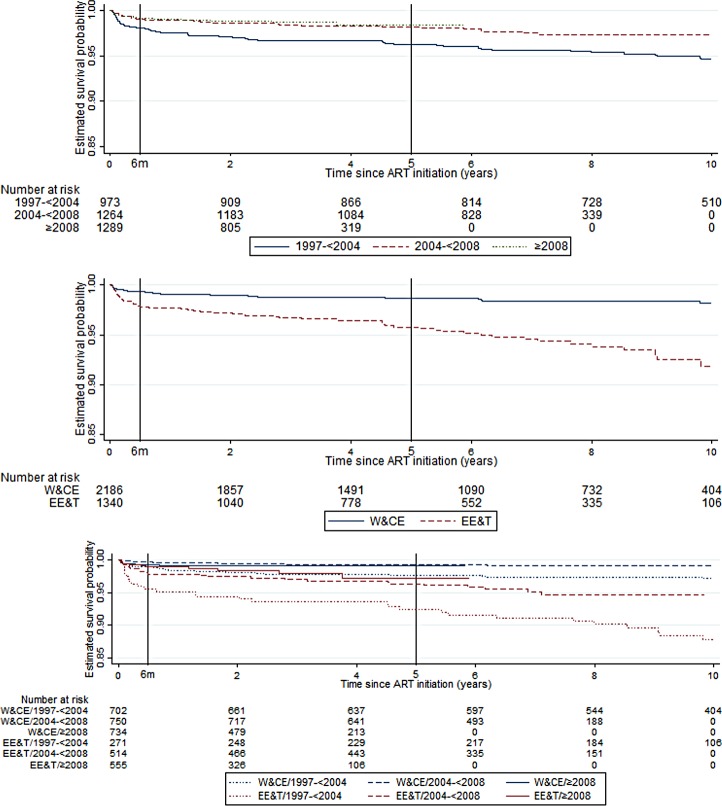
Kaplan-Meier survival curve for time from cART initiation to death (A) by calendar period of cART initiation, (B) by country group*, and (C) by calendar period and country group. ART, antiretroviral therapy; cART, combination antiretroviral therapy; EE&T, Eastern Europe and Thailand; W&CE, Western and Central Europe.